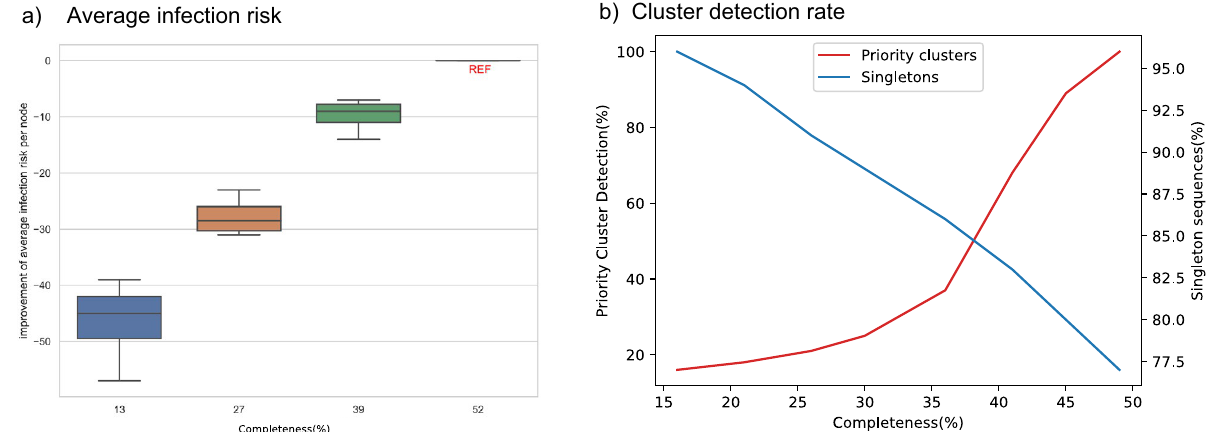
Figure 4. Houston/Harris County (2012–2019) data: ( a ) average infection risk improvement, ( b ) cluster detection trend (left y-axis) and Singleton sequence rate versus different data completeness rates (right y-axis) vs various genotype data completeness.